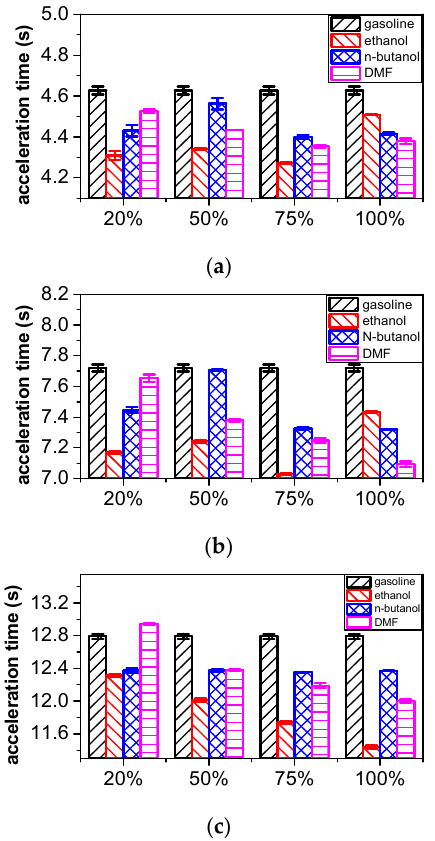
Figure 14. Acceleration time of three, four, and five gears: (a) Acceleration time of three gears; (b) Acceleration time of four gears; (c) Acceleration time of five gears.